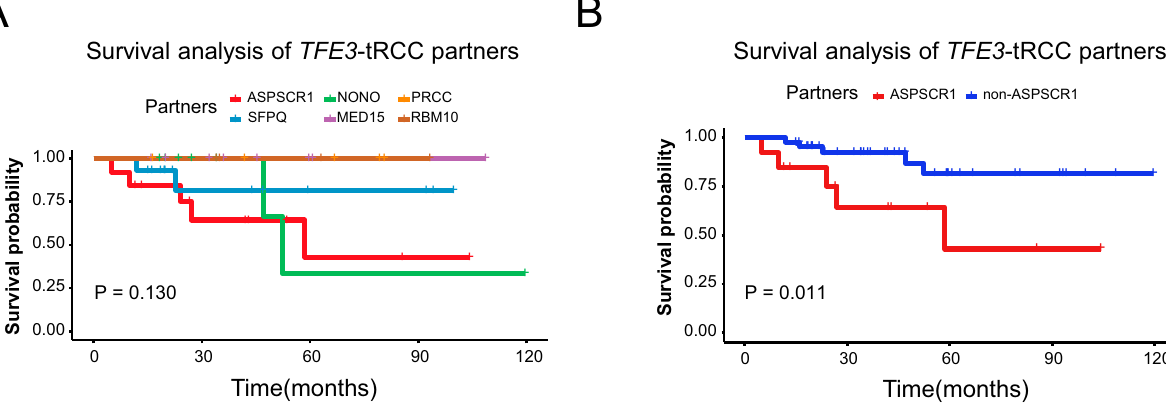
Fig. 2 Survival analysis of TFE3 -tRCC partners. A Kaplan – Meier curves show the OS for patients with different TFE3 -fusion subtypes. A Kaplan – Meier curves show the OS for patients with ASPSCR1 - TFE3 fusion and non- ASPSCR1 - TFE3 fusion. P -value was determined by two-sided log-rank test ( A , B ). TFE3 - tRCC TFE3 -translocation renal cell carcinoma, OS overall (Supplementary Figure 3A). Radiologically, cases with ASPSCR1- TFE3 fusion presented with features typical of hypervascularity and calci fi cation on CT scan, while MED15-TFE3 fusion tRCC often presented as cystic masses (Supplementary Figure 3B).